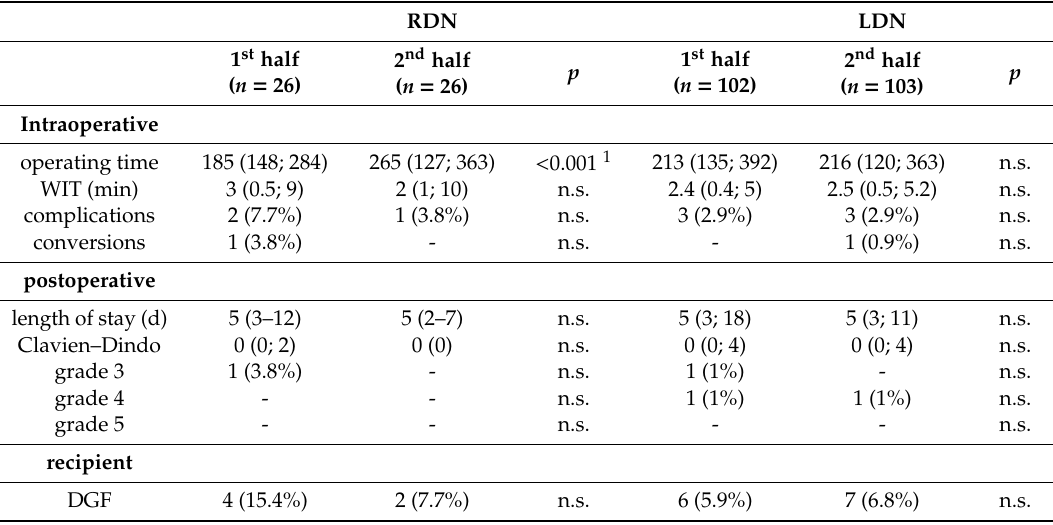
Table 3. Assessment for the inherent learning curves in RDN and LDN by comparing the first with the second half of cases within each